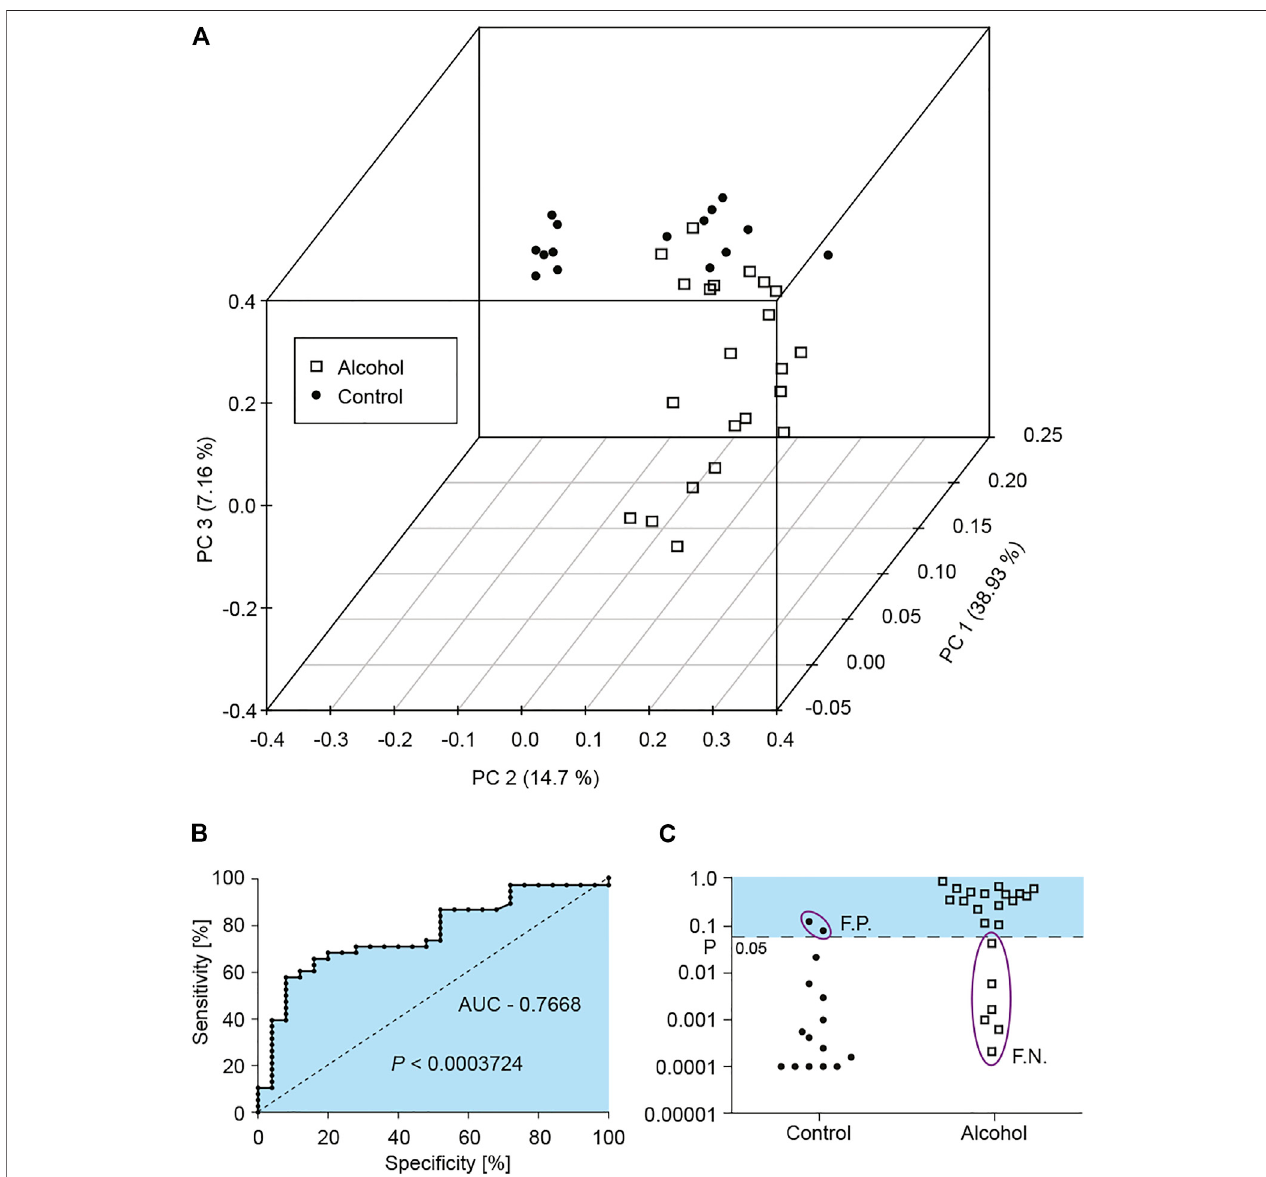
FIGURE 6 | Ef fi cacy of the current microRNA panel to segregate alcohol abusers and non-abusing controls. (A) 3D graph of Principal Component Analysis (PCA, PC1 — 38.93%, PC2 — 14.7%, and PC3 — 7.16% of the total variance) shows that most alcohol and control individuals can be classi fi ed into separate clouds with some overlap. (B) A Receiver Operating Curve (ROC) of alcohol-regulated microRNA panel indicates the ability of the panel to distinguish between the alcohol group and the controlgroup:theareaundertheROCcurve (AUC, blue)issigni fi cantlyaboverandomsampling: 0.7668( p < 0.0003724). (C) The fi tofeachindividualtoanoverall alcohol-regulated microRNA panel is shown as a p -value of departure of individual ROC curve from the panel ’ s ROC with p (cid:2) 0.05 used as a cut-off for signi fi cance (dottedline).If p ≥ 0.05themicroRNApaneldeterminestheindividualasanalcoholabuser,if p < 0.05themicroRNApanelclassi fi estheindividualasanon-abuser.False positives and false negative results are